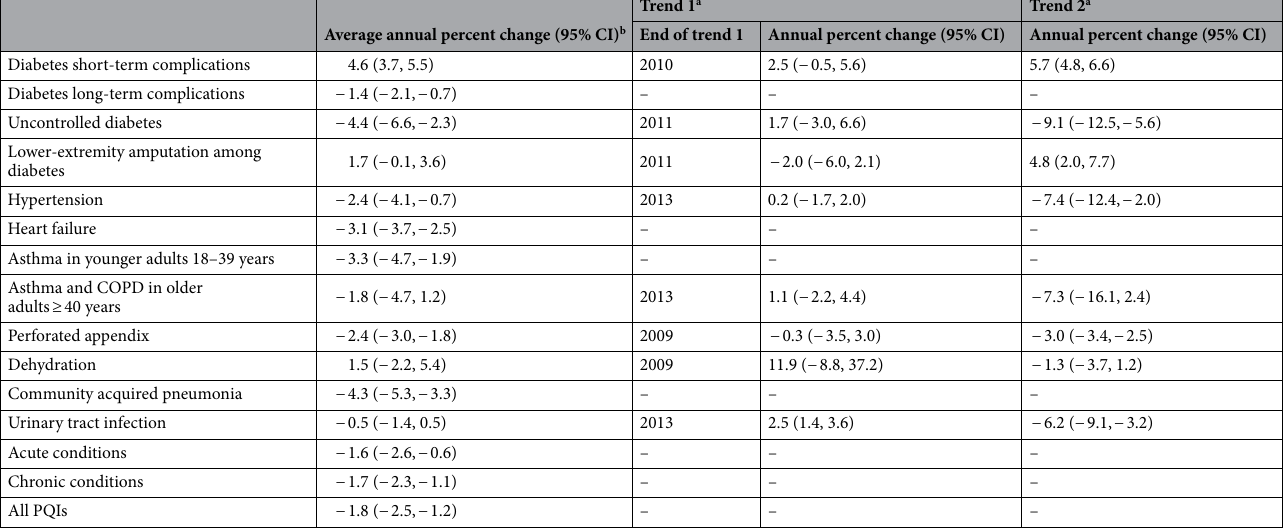
Table 2. Results of joinpoint trend analysis for PQI hospitalization rates in the United States, 2007–2016. COPD chronic obstructive pulmonary disease. a The year 2007 always constitutes the starting point for Trend 1 if a significant joinpoint is present. The year 2016 always constitutes the ending point for Trend 2 if a significant joinpoint is present. The ending point of Trend 1 constitutes the starting point for Trend 2. b The average annual percentage change is equal to the annual percentage change over the entire period if a joinpoint is not